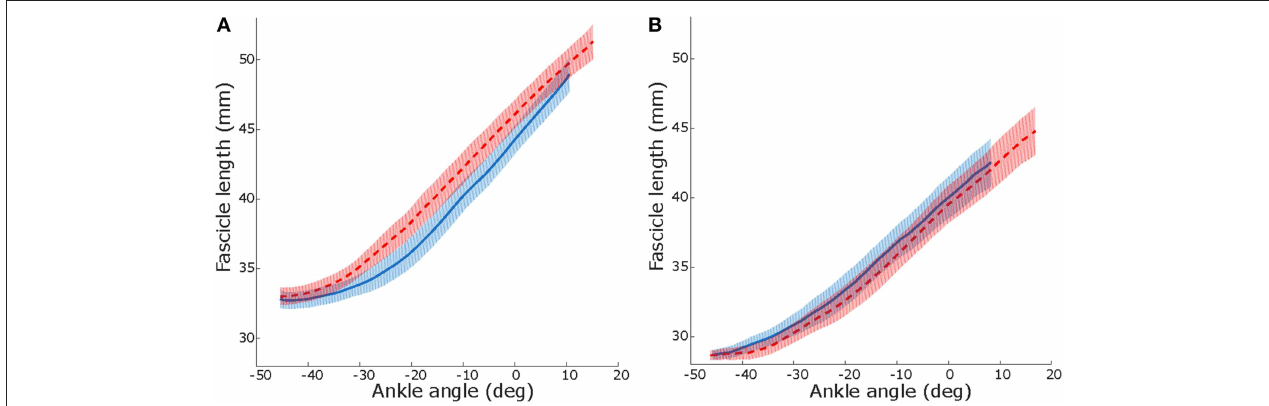
FIGURE 3 | Median and IQR over all participant, lengthening profiles of muscle fascicles vs. ankle angle during a passive joint rotation in the intervention (A) and control (B) group. Negative angles reflect plantarflexion position. Solid blue: baseline, dashed red: after 10 weeks of intervention. See online version for color.